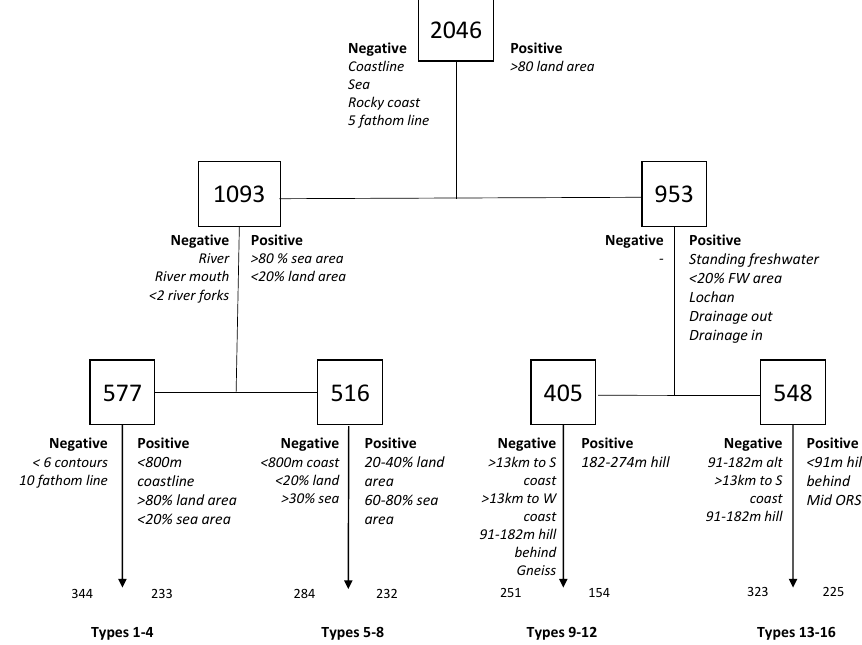
Figure 3. Hierarchy of divisions in the land classification (numbers refer to number of 1m grid squares).